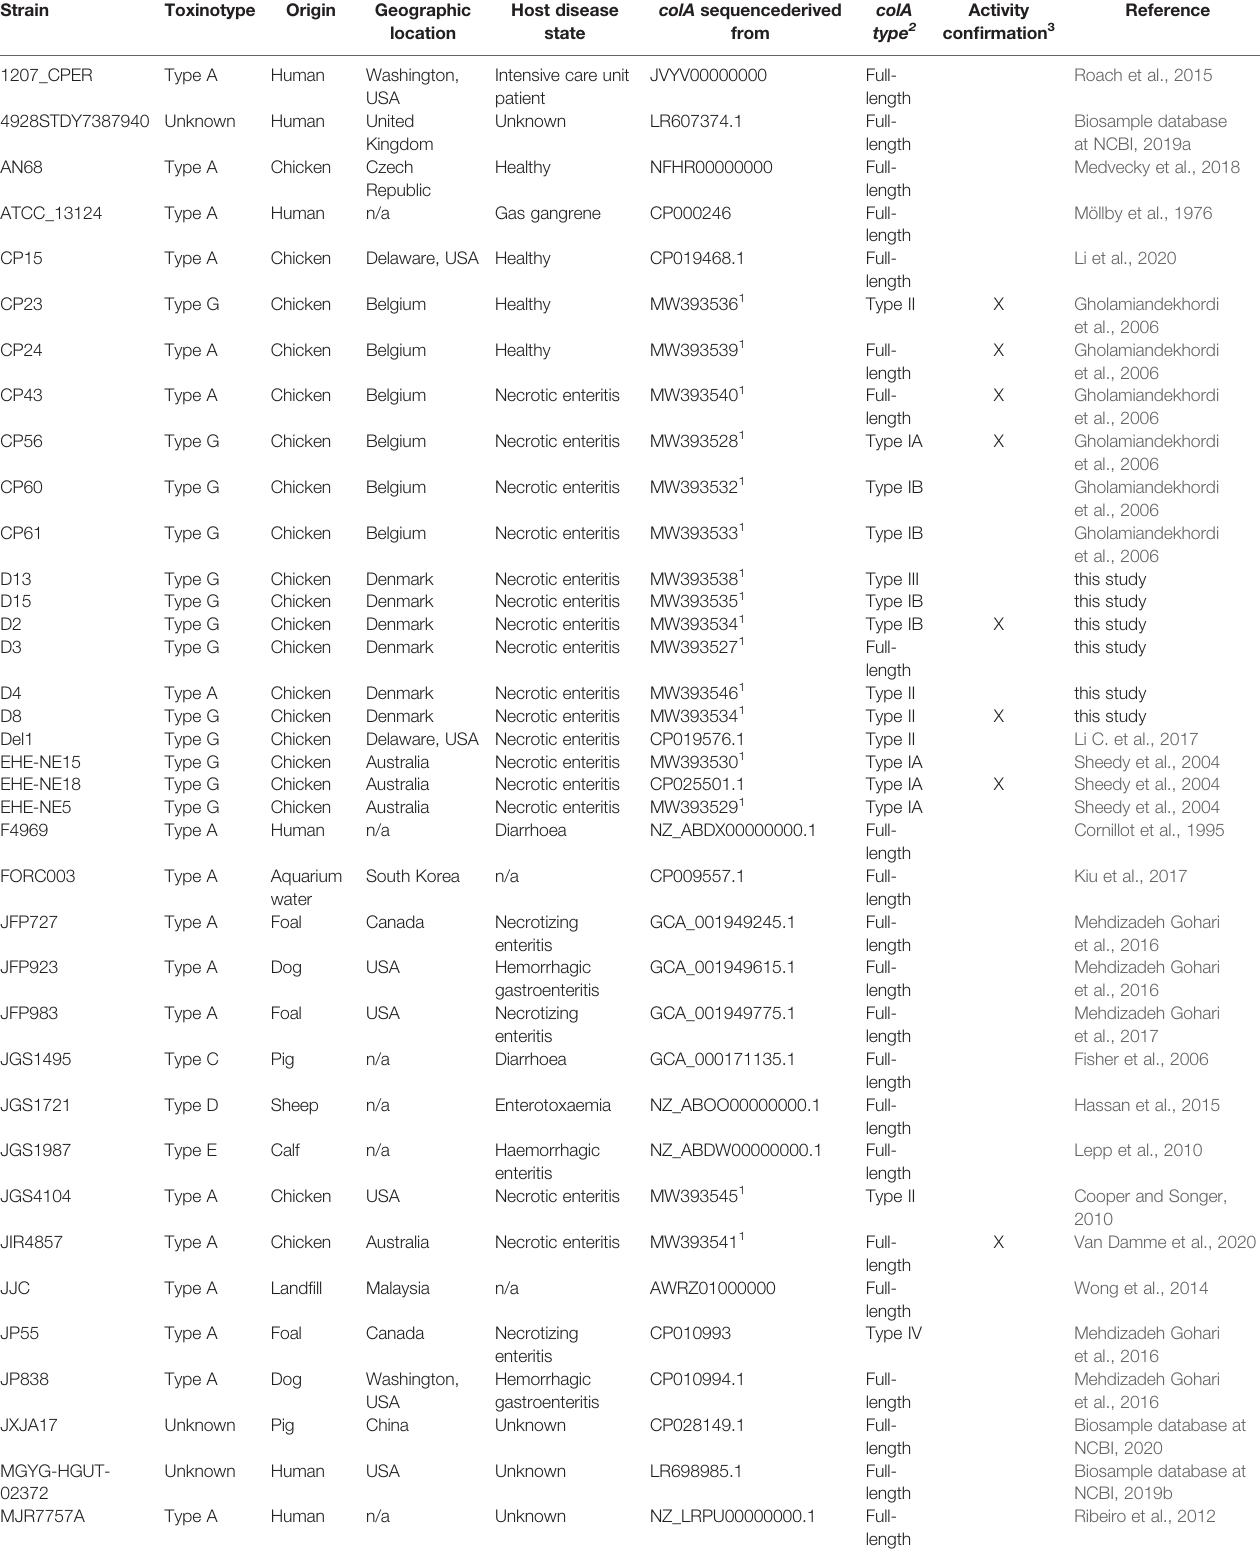
TABLE 1 | Characteristics of C. perfringens strains used in this